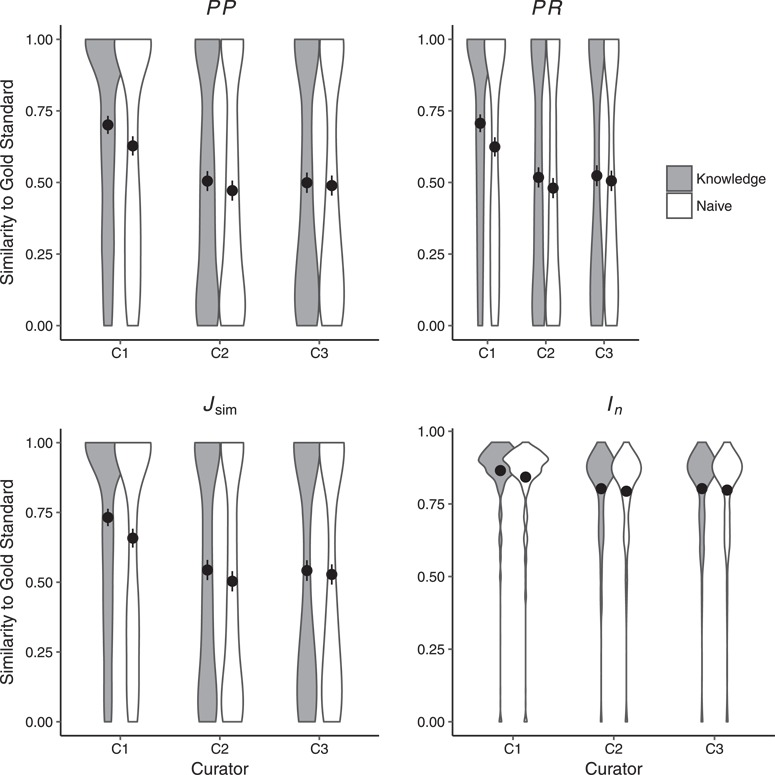
Similarity of human annotations to the gold standard in Naïve and Knowledge rounds. Shown are means across all 463 character states. Error bars represent two standard errors of the mean. Curators C1 (as per PP, PR, \documentclass[12pt]{minimal}
\usepackage{amsmath}
\usepackage{wasysym}
\usepackage{amsfonts}
\usepackage{amssymb}
\usepackage{amsbsy}
\usepackage{upgreek}
\usepackage{mathrsfs}
\setlength{\oddsidemargin}{-69pt}
\begin{document}
}{}$J_{\mbox{sim}}$\end{document} and \documentclass[12pt]{minimal}
\usepackage{amsmath}
\usepackage{wasysym}
\usepackage{amsfonts}
\usepackage{amssymb}
\usepackage{amsbsy}
\usepackage{upgreek}
\usepackage{mathrsfs}
\setlength{\oddsidemargin}{-69pt}
\begin{document}
}{}$I_n$\end{document}) and C2 (as per PR, \documentclass[12pt]{minimal}
\usepackage{amsmath}
\usepackage{wasysym}
\usepackage{amsfonts}
\usepackage{amssymb}
\usepackage{amsbsy}
\usepackage{upgreek}
\usepackage{mathrsfs}
\setlength{\oddsidemargin}{-69pt}
\begin{document}
}{}$J_{\mbox{sim}}$\end{document}) were significantly closer to the gold standard in the Knowledge round as compared to the Naïve round. Detailed results are shown in Supplementary Materials, Table 2.